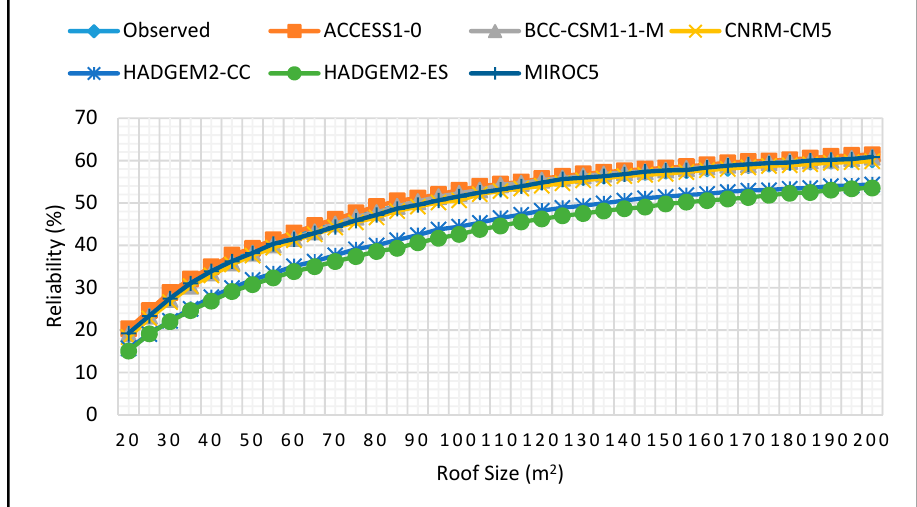
Figure 10. Reliability projections for DJF season for 0.5 m 3 tank size for 2025–2055.